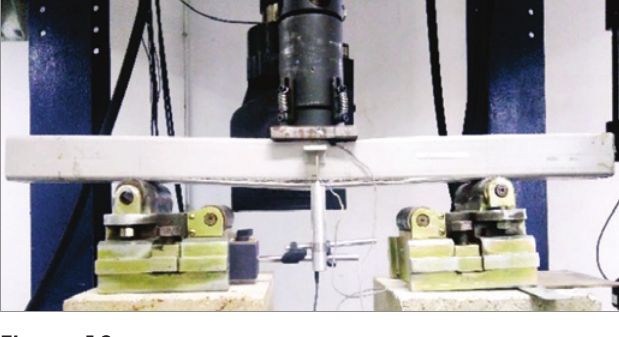
Hybrid sleeper reduced model after failure load of the hybrid beam with 1% fibers of 25 mm long is due to the smaller compressive strength of the concrete of these beams. Figure 14 and Figure 15 present the load x vertical displacement and load x strain curves of the hybrid beams, respectively. All hy - brid beams presented similar stiffness, but the beams with added fibers showed greater ductility near the failure.